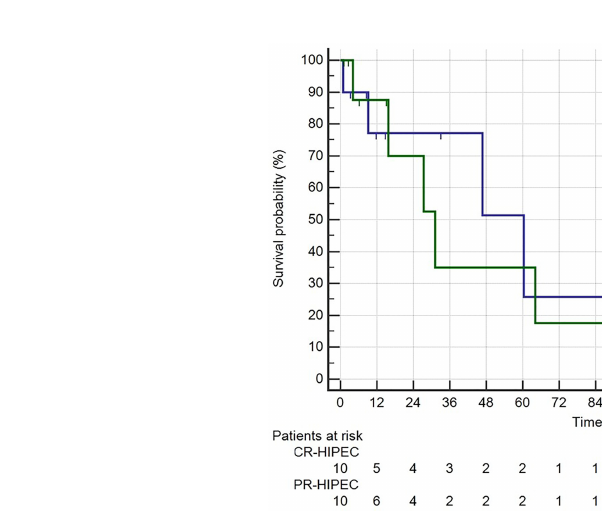
FIGURE 3 | Survival rates for Group 1: CR-HIPEC, completely regressed followed by surgery plus HIPEC; Group 2: PR-HIPEC, partially regressed followed by surgery plus